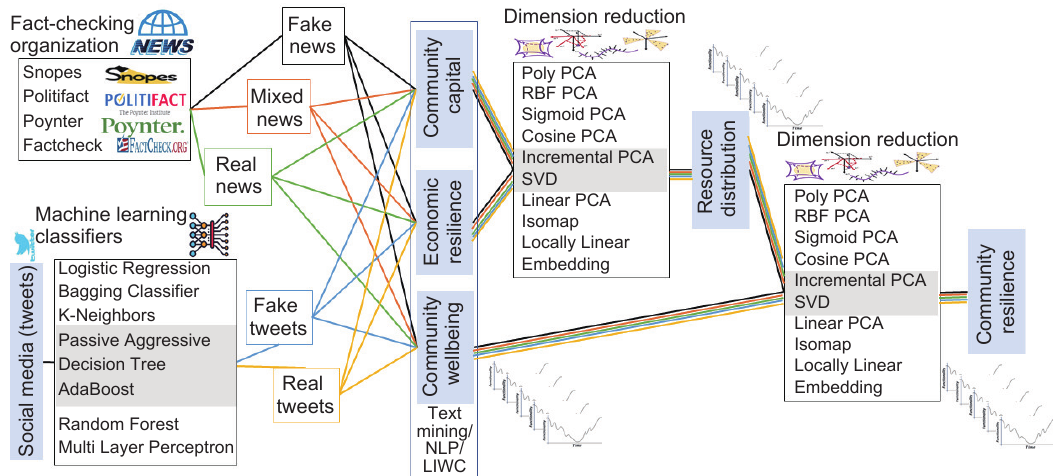
Fig. 1 Proposed framework for assessing community resilience of various types of news/tweets via machine learning, natural language processing, and dimension reduction